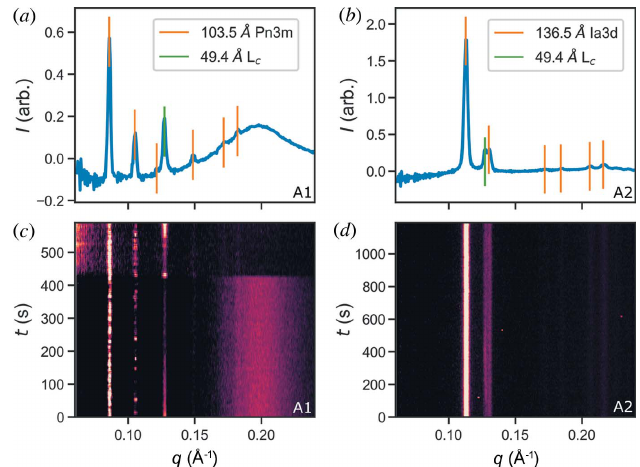
Figure 3 Radial diffraction profiles showing the coexistence of crystal lamellar (L c ) and cubic ( Pn 3 m and Ia 3 d ) phases when injected into air at the Australian Synchrotron: ( a , c ) sample A1, ( b , d ) sample A2. Both samples were mixed with the ratio of 60:40 MO/water ( w / w ). Panels ( a ) and ( b ) represent the average diffraction profile. Vertical lines indicate the peak positions implied by the crystallographic space group and the stated lattice parameter. Panels ( c ) and ( d ) show the evolution of the diffraction profiles over the course of the data collection of a single sample and indicate the simultaneous presence of the lamellar and cubic